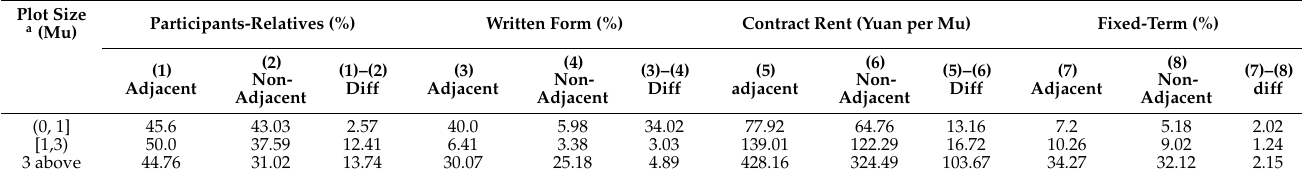
Table 4. The plot sizes with different positions and contract